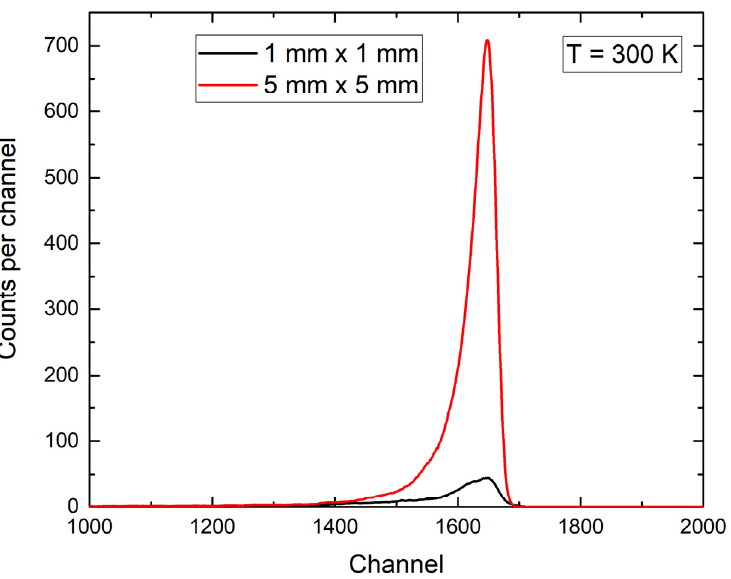
Figure 5. Responses of 4H-SiC detectors with different active surface areas of 1 mm × 1 mm and 5 mm × 5 mm to Am-241 alpha particles. We observed an excellent correlation of the different detector size responses to the Am-241 alpha particle energy maxima of 5486 keV (channel 1651 for 1 mm × 1 mm and channel 1648 for 5 mm × 5 mm SBDs).